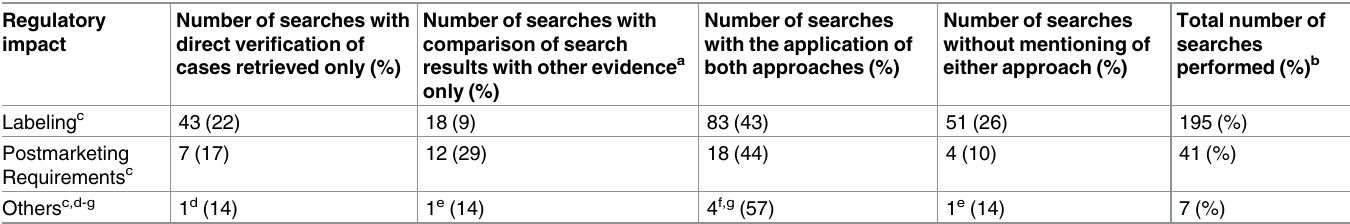
Table 4. Characteristics of searchesperformed with regulatory